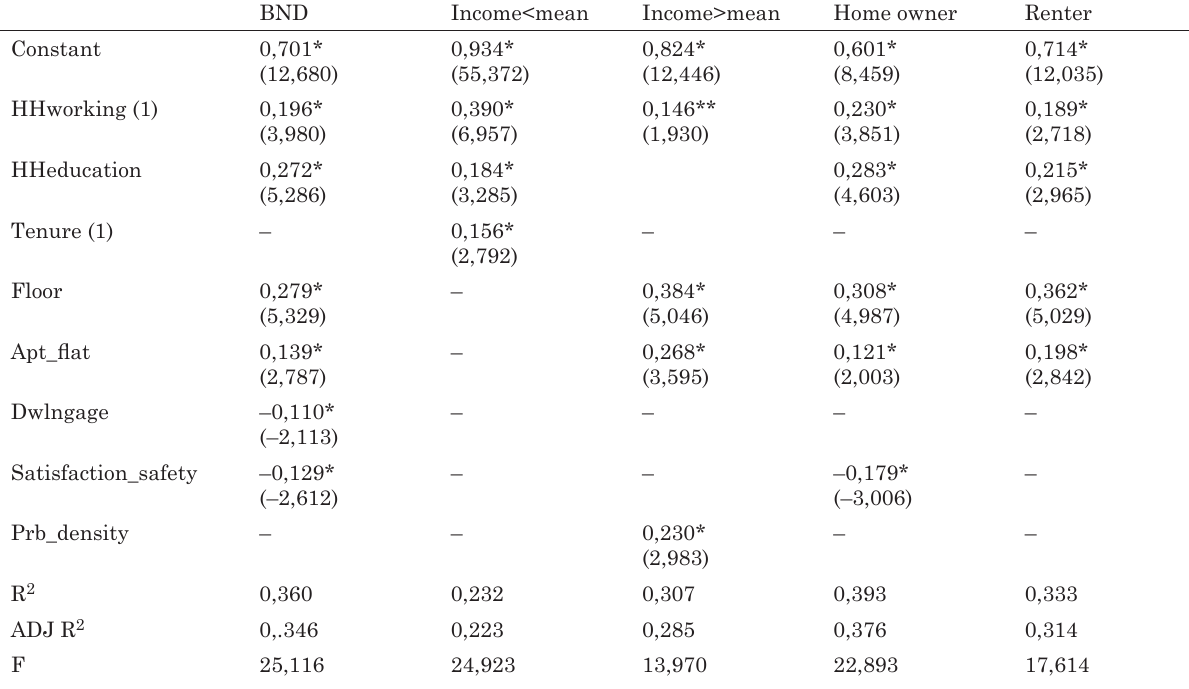
The significant variables are included in the table. Coefficients reflect standardized β values. t values are in parenthesis. * Significant at 1% level. ** Significant at 5%